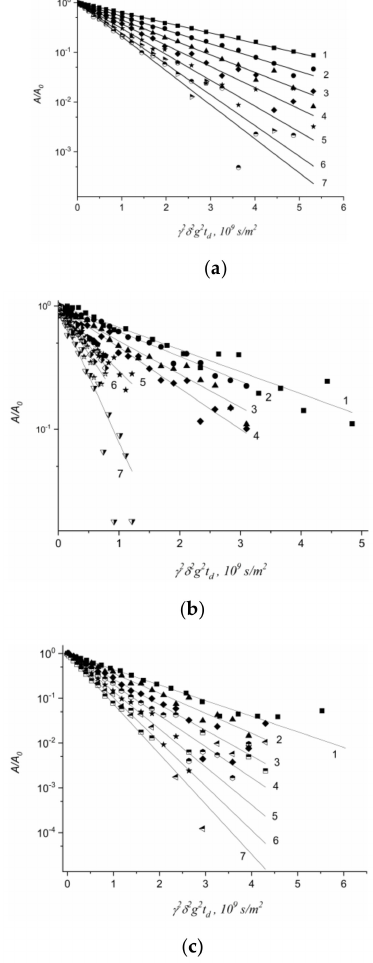
Figure 40. Diffusion decays of 7 Li ( a ), 23 Na ( b ), 133 Cs ( c ) nuclei NMR signals in appropriate ionic form of MSC membrane at RH = 95% and different temperatures (1) 20 ◦ C, (2) 30 ◦ C, (3) 40 ◦ C, (4) 50 ◦ C, (5) 60 ◦ C, (6) 70 ◦ C, (7) 80 ◦ C